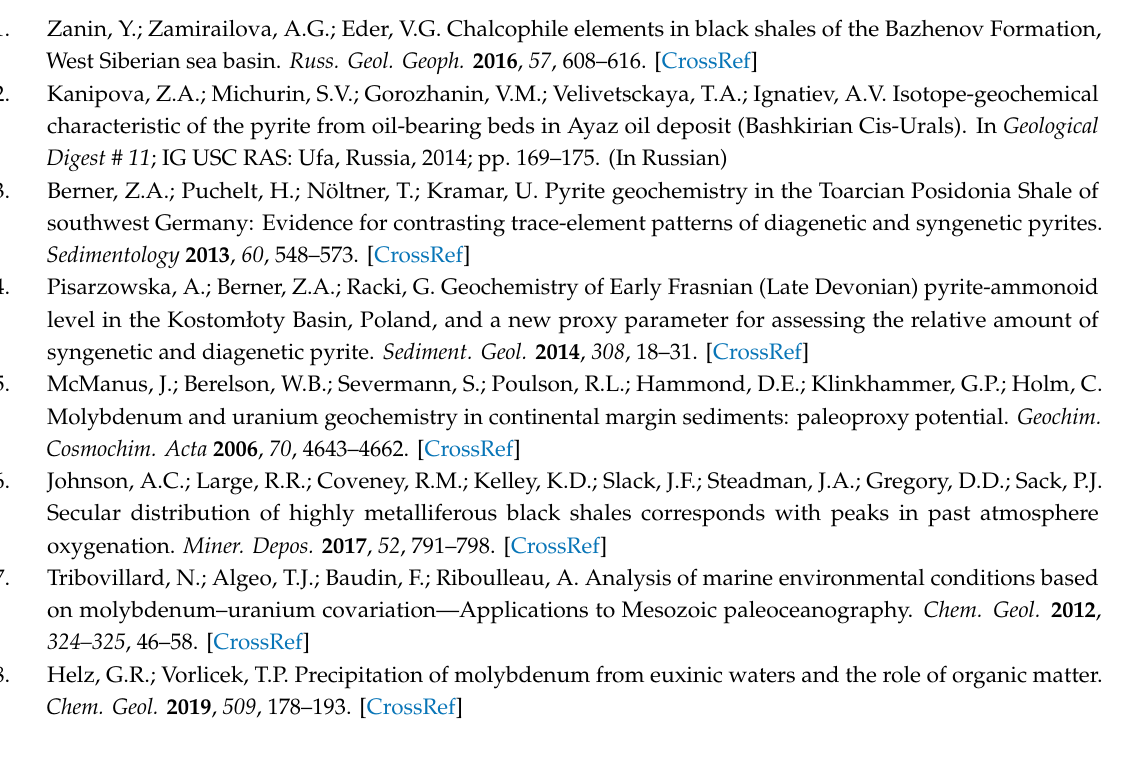
Table S1: Trace elements with correlation analysis in framboid pyrite Bazhenov Formation; Table S2: Trace elements with correlation analysis in nodular pyrite Bazhenov